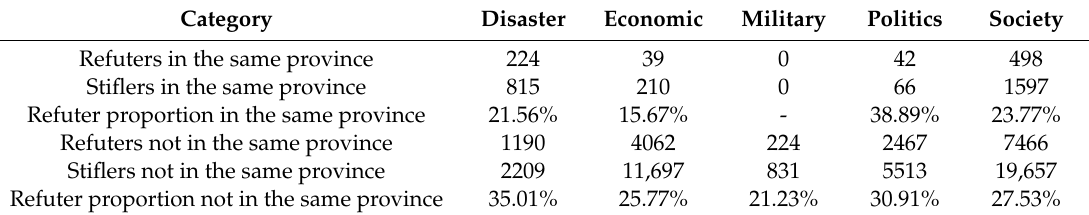
Table 6. Refuter proportions in the same province as the anti-rumor